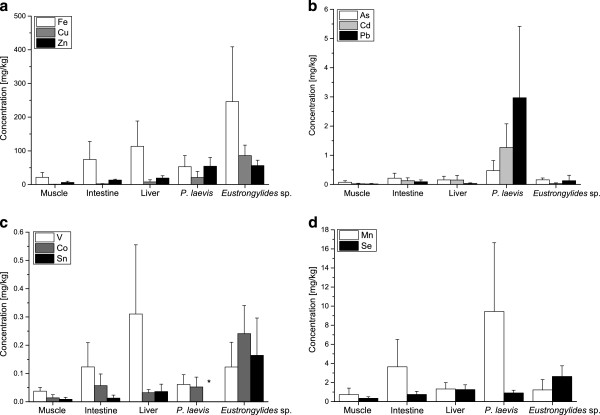
Mean (±S.D.) element concentrations (a–d) in organs of barbels and in its parasites Pomphorhynchus laevis and Eustrongylides sp. *Concentrations are not displayed, as they were below the detection limit